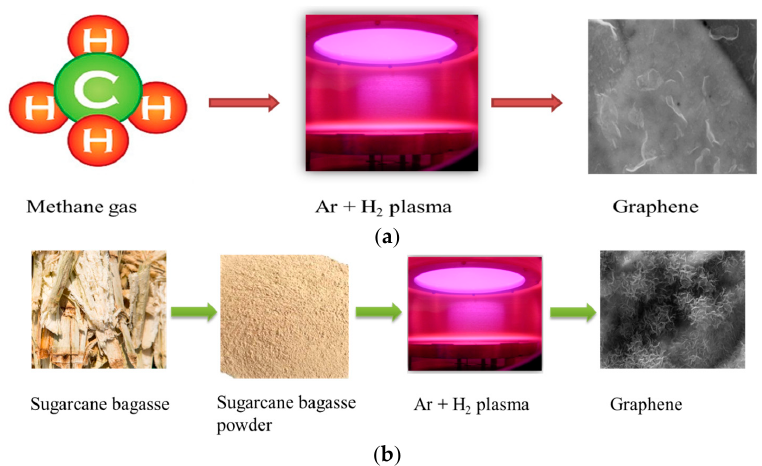
Figure 6 . Schematic representation of plasma enabled synthesis of graphene . ( a ) Conversion of Figure 6. Schematic representation of plasma enabled synthesis of graphene. ( a ) Conversion of methane methane gas into graphene in the presence of plasma . ( b ) Reforming of sugarcane bagasse into gas into graphene in the presence of plasma. ( b ) Reforming of sugarcane bagasse into graphene .